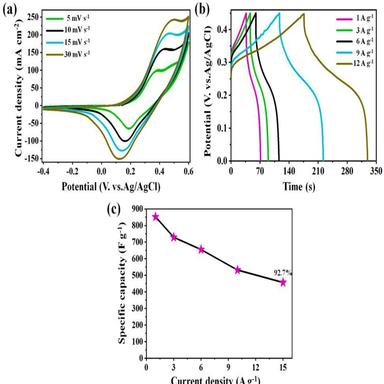
(a) CV plots of Mn-Co Oxides NSFAs electrode sample at various scans, 5–30 mV s − 1 , (b) charged-discharged result values of Mn-Co Oxides NSFAs electrode at various specific currents, and (c) specific capacitances versus specific current values.